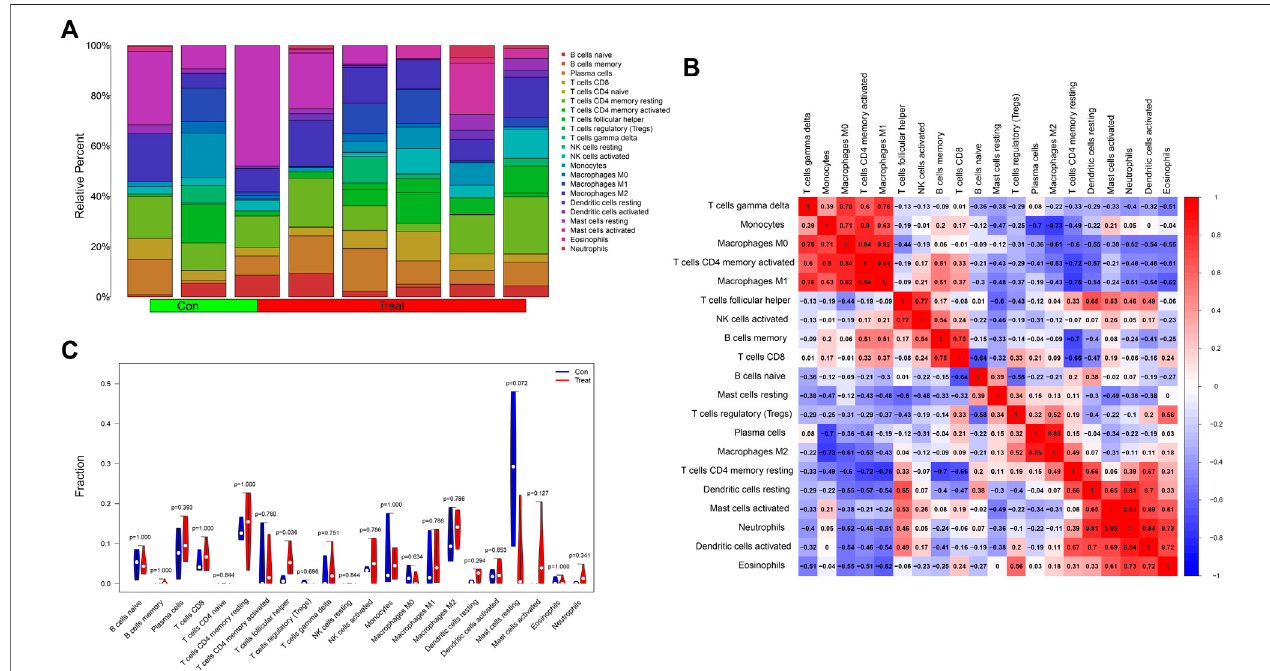
FIGURE 8 | (A) A histogram showing the contents of 22 kinds of in fi ltrating immune cells in the samples with a threshold p value < 0.05. (B) The heatmap showed the correlations between immune in fi ltrating cells. Red represented positively related while blue represented negatively related. (C) The differential analysis of immune cells was presented in the form of a violin diagram. The Y-axis represented the fractions of immune in fi ltrating cells.